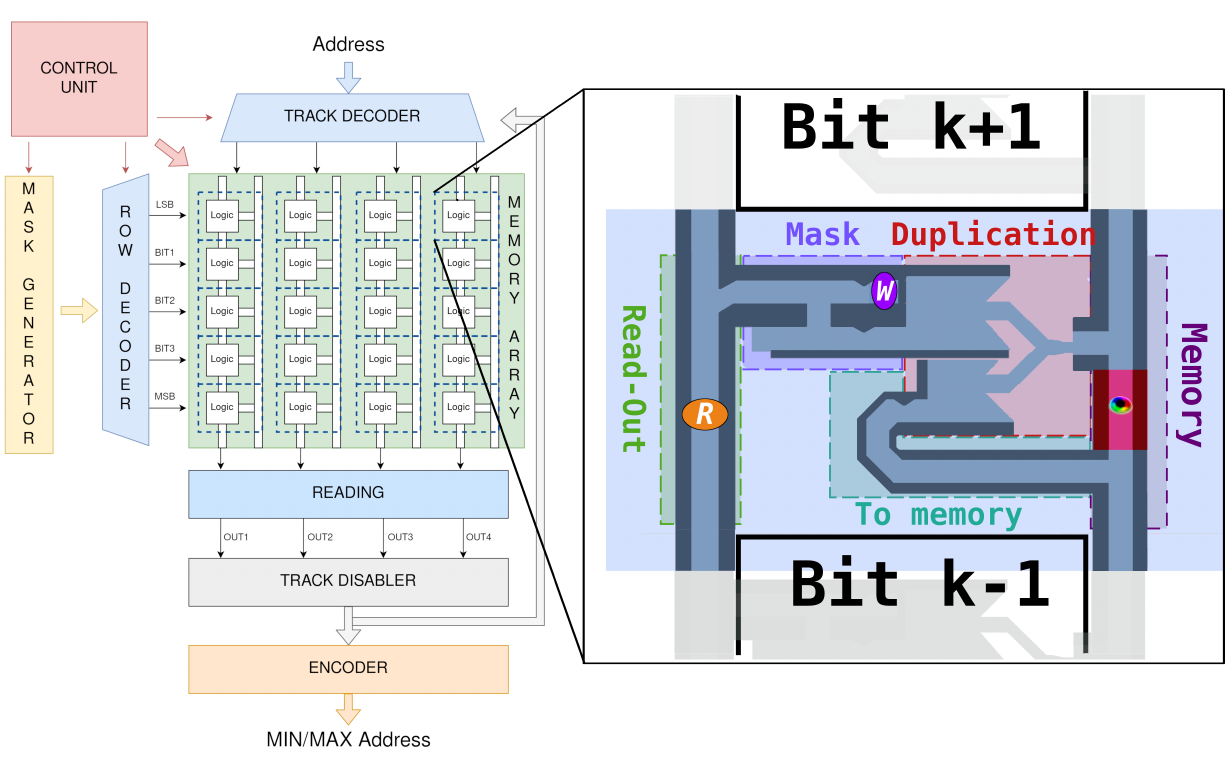
Figure 6. Logic in memory architecture schematic. On the left the block diagram of the complete circuit. On the right the basic cell of the array. The skyrmion is stored inside the memory in correspondence of the red